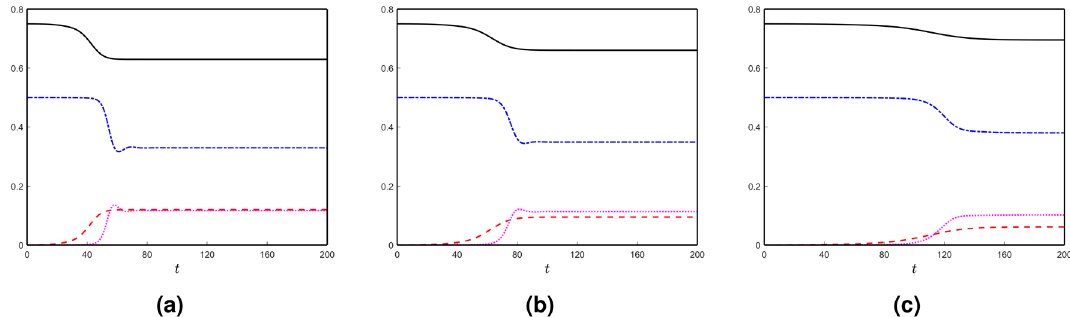
Figure 2. (Color online) Spatial averages of the solutions of the local model with different values of c u and c v : ( a ) c u = c v = 0 , ( b ) c u = c v = 0.1 and ( c ) c u = c v = 0.2 . The curves (solid), (dashed-dashed), (dashed-dotted) and (dotted) are corresponding to the spatial averages of u ,